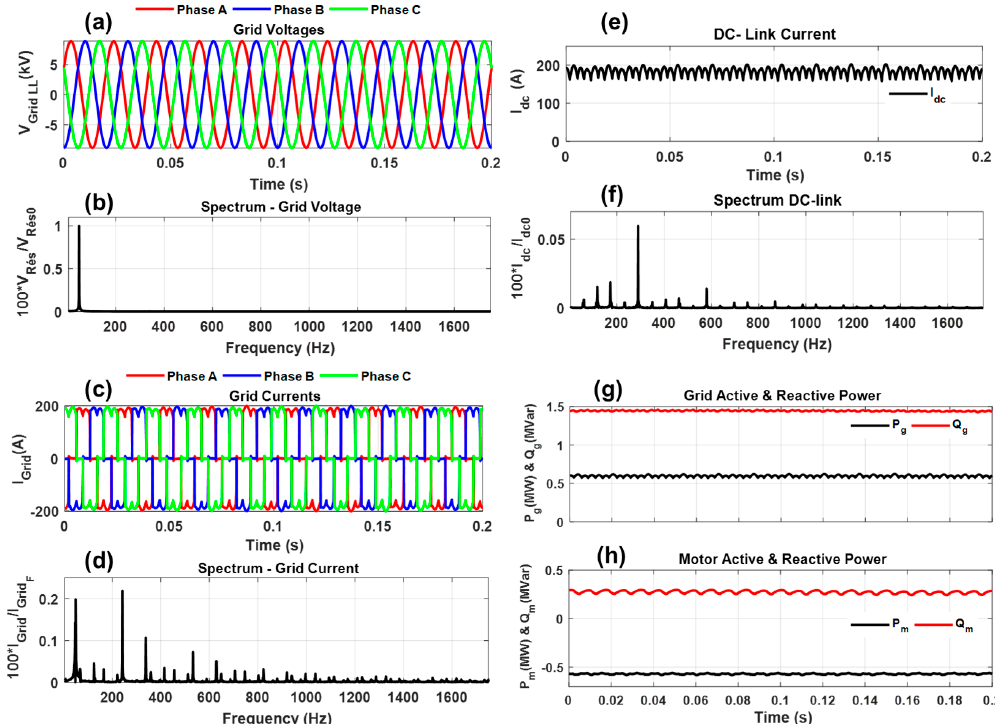
Figure 14. Sample simulation results of a 6/6-pulse LCI system at 40 Hz: ( a ) grid voltages, ( b ) spectrum of grid voltage, ( c ) grid currents, ( d ) spectrum of grid current, ( e ) DC-link current, ( f ) spectrum of DC-link current, ( g ) grid active power and reactive power and ( h ) motor active power and reactive power.